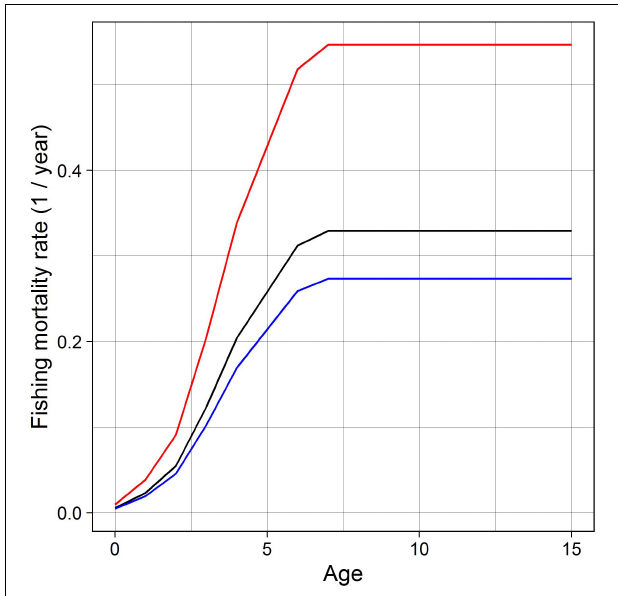
FIGURE 2 | Mean F at age over 2001–2018 (black line) , from which F MSY (blue line) is calculated with a multiplier of 0.83, and F lim (red line) with a multiplier of 1.66.